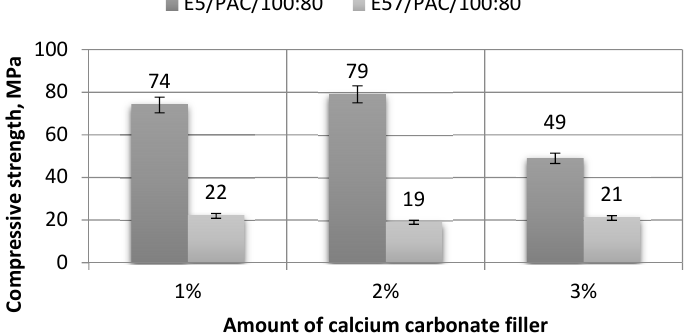
Figure 21. Comparison of the compressive strain between the E5/PAC/100:80 and E57/PAC/100:80 epoxy specimens modified by the calcium carbonate filler post ‐ thermal shock chamber aging.